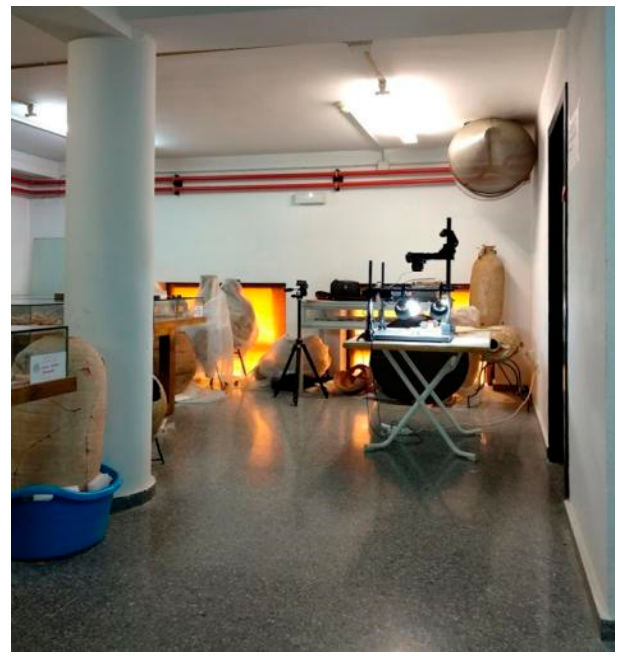
Figure 2. Museum of Prehistory acquisition room used to record the piece.